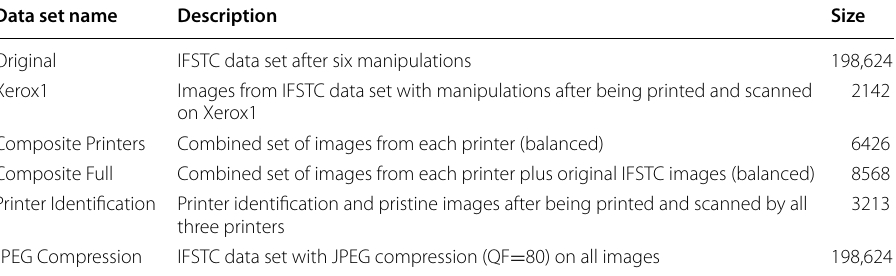
Size refers to the number of 299 299 or 256 256 image blocks in each data set, which is then split in 75% training and × × 25% validation. X1 and X2 refer to Xerox1 and Xerox2 printers (Sect. 3.6), respectively. The labels refer to the labels used when training and evaluating on each data